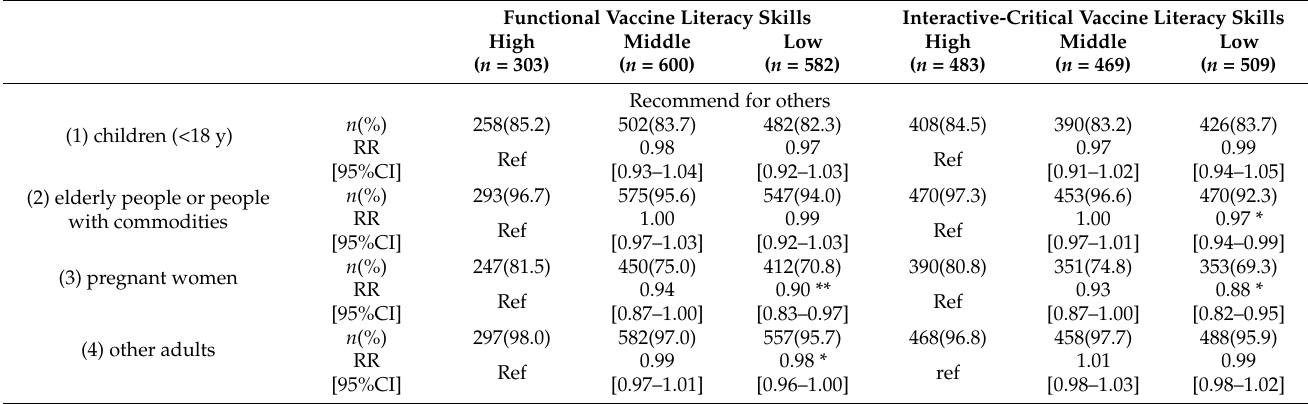
Table 2. Cont. Functional Vaccine Literacy